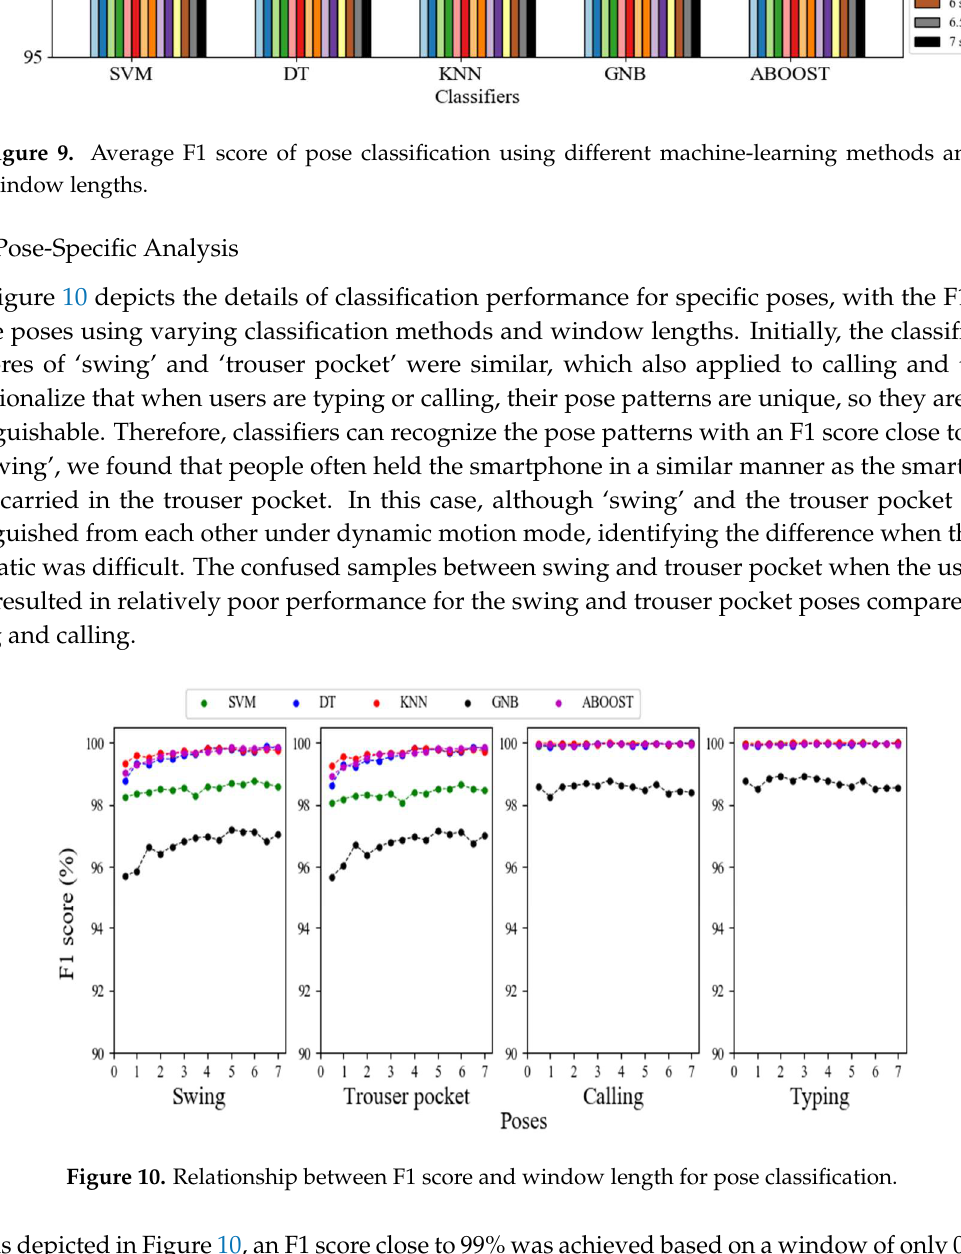
Figure 9. Average F1 score of pose classification using different machine-learning methods and window lengths.